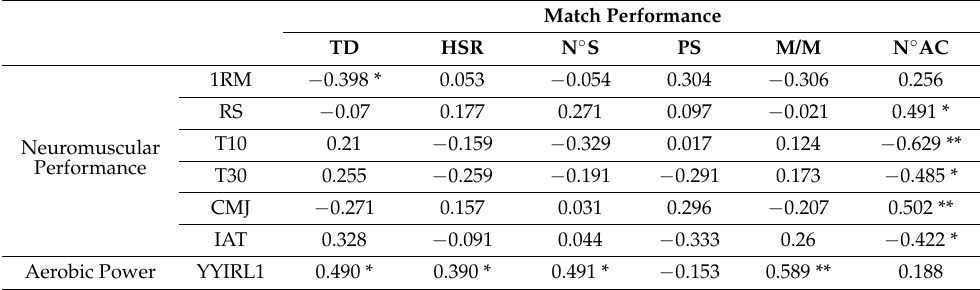
Table 3. Correlations between physical fitness and performance parameters in official matches.